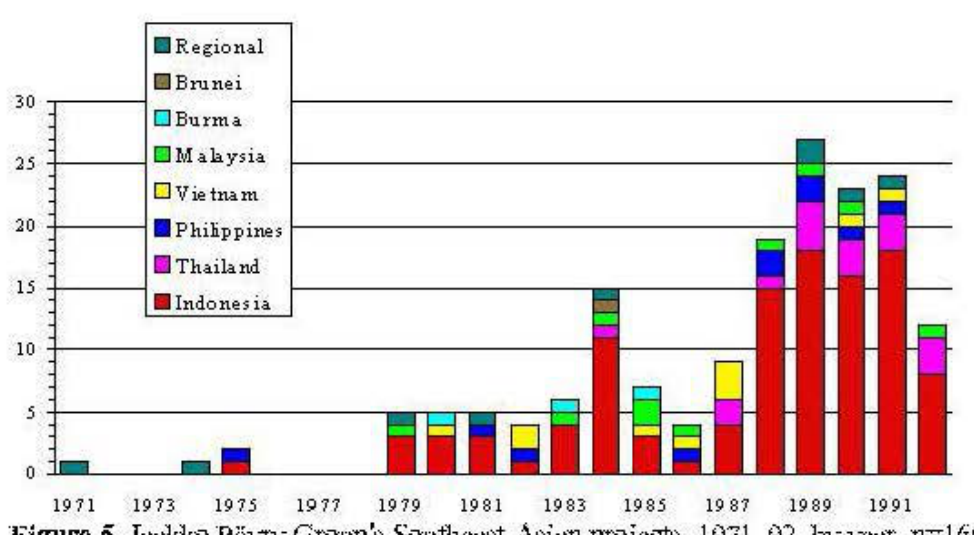
figure 5. Jitikko Pi\y1yGmup's Southeast Asian prnjccts. l 971-92. byy-car. n=l(i9